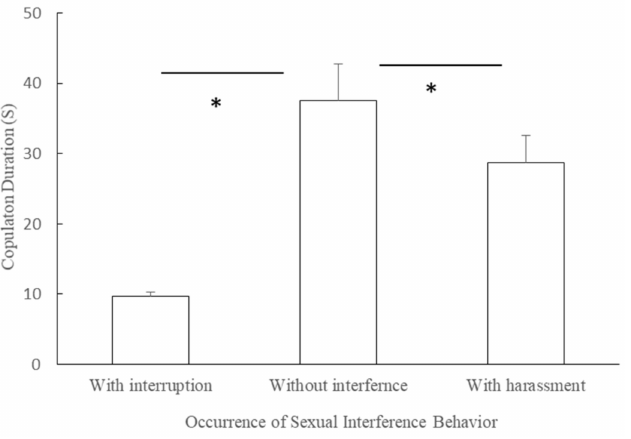
Figure 6. Differences in copulation durations with and without interference (*: p < 0.05). The duration of copulations with harassment (mean ± SE = 28.75 ± 3.780 s, n = 11) was shorter than the duration of copulations without harassment in the mating season (mean ± SE = 37.590 ± 5.230 s, n = 11, t = − 2.360, df = 10, p = 0.040, Figure 6).